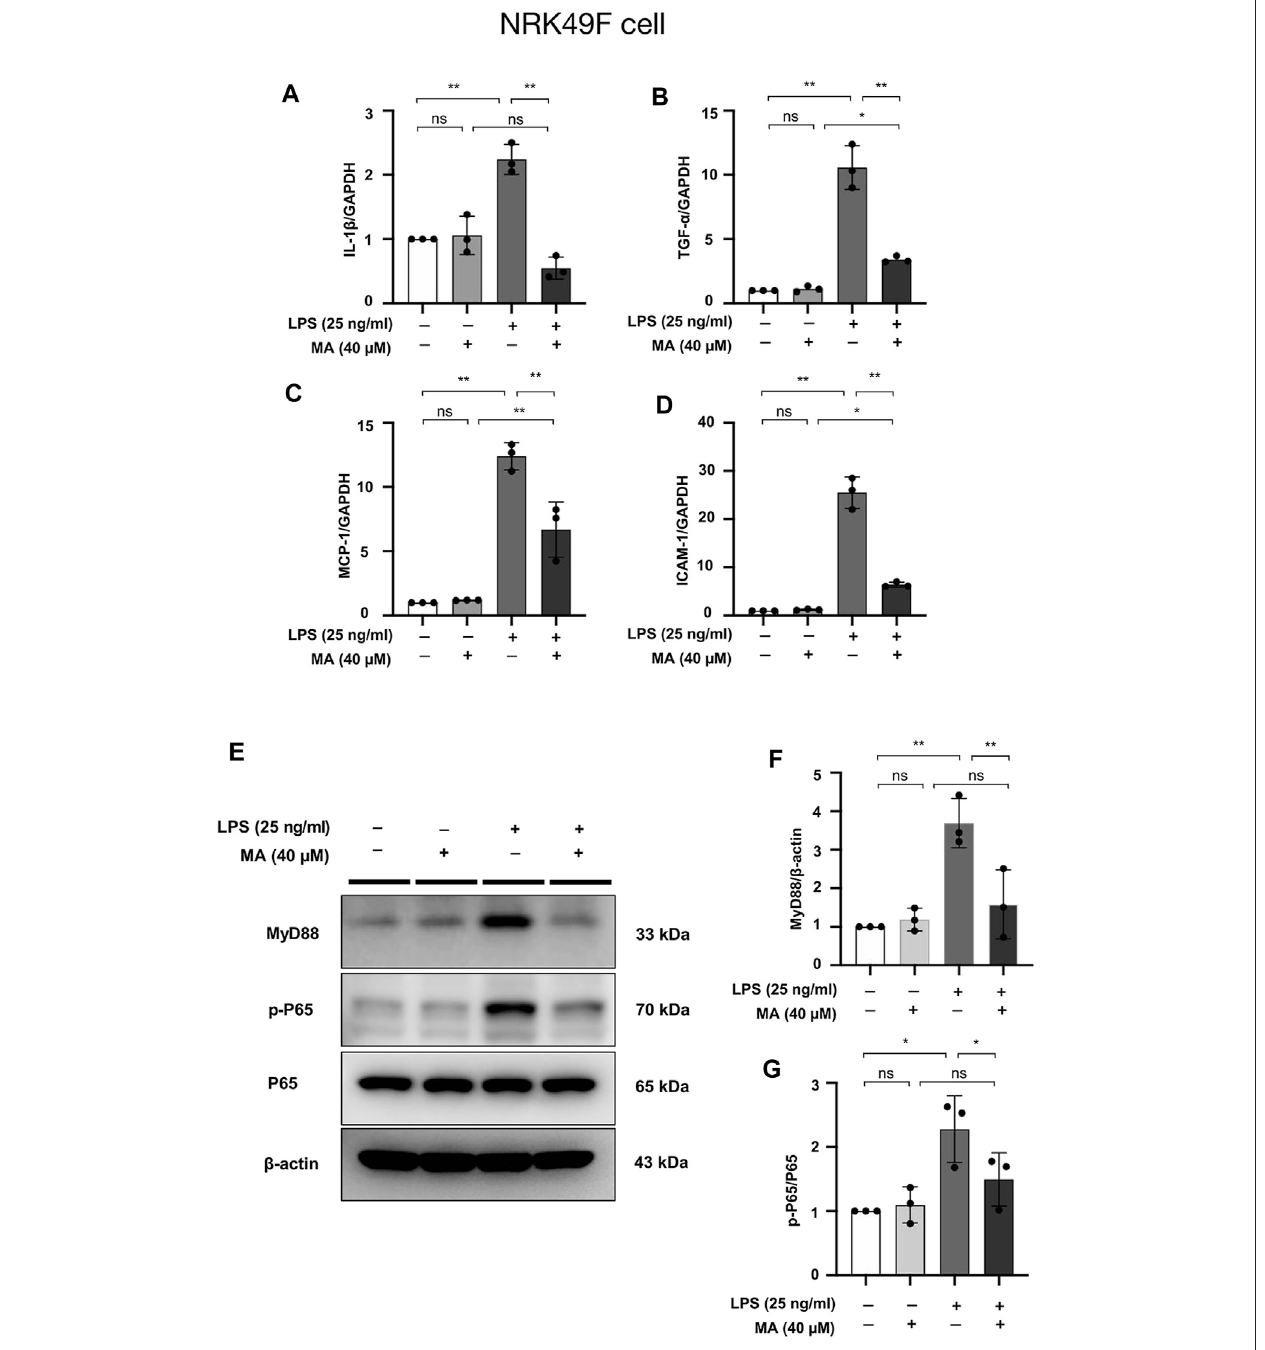
FIGURE9| MAattenuatesLPS-inducedin fl ammationinNRK49Fcellsand suppressesNF- κ BSignaling. (A – D) mRNAexpressionlevelsofIL-1 β ,TNF- α ,MCP- 1 and ICAM-1 were evaluated in LPS-treated NRK49F cells and determined by RT-PCR. Cells were pretreated with MA for 2 h after starvation with 0.5% FBS medium, then treated with LPS (25 ng/ml) for 2 h. Results were normalized to GAPDH expression. The data are presented as the mean ± SD, n (cid:1) 3. * p < 0.05, ** p < 0.01, ns: no signi fi cance. MA, maslinic acid; LPS, Lipopolysaccharide; RT-PCR, Real-Time PCR. (E) Expression of p-P65, P65 and MyD88 in LPS-treated NRK49F cells was detected by western blot and quanti fi ed by densitometry. Cells were pretreated with MA for 2 h after starvation with 0.5% FBS medium and then treated with LPS(25 ng/ml)for 2 h. (F,G) Statisticalsigni fi cance waspresented asthemean ± SD, n (cid:1) 3.* p < 0.05,** p < 0.01,ns: nosigni fi cance. MA, maslinicacid; LPS,